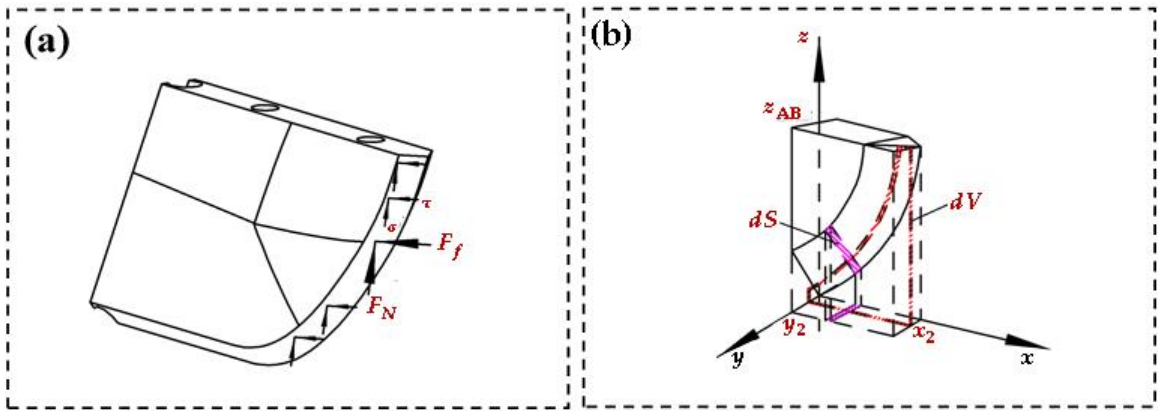
Figure 17. Analysis of the interaction between the sliding–cutting force and soil. ( a ) The force of the sliding–cutting edge. ( b ) The interaction analysis between the sliding–cutting edge and the